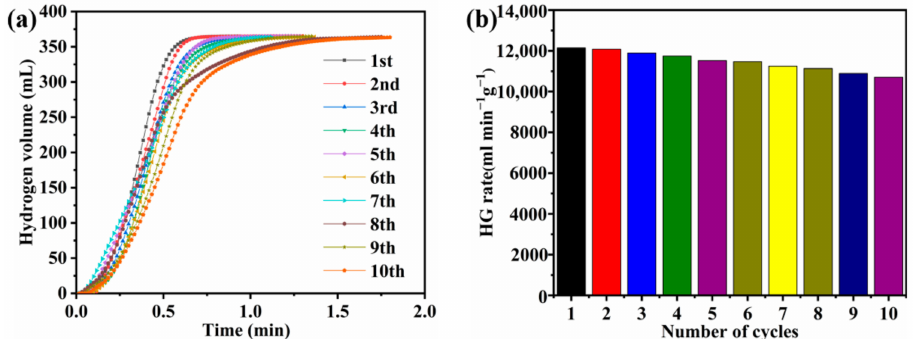
Figure 12. ( a ) Reusability of Co-B-P/75rGO with 0.1 g catalyst and 1.5 wt% NaBH 4 + 5 wt% NaOH solution at 25 ◦ C; ( b ) HG rate bar chart of catalyst used 10